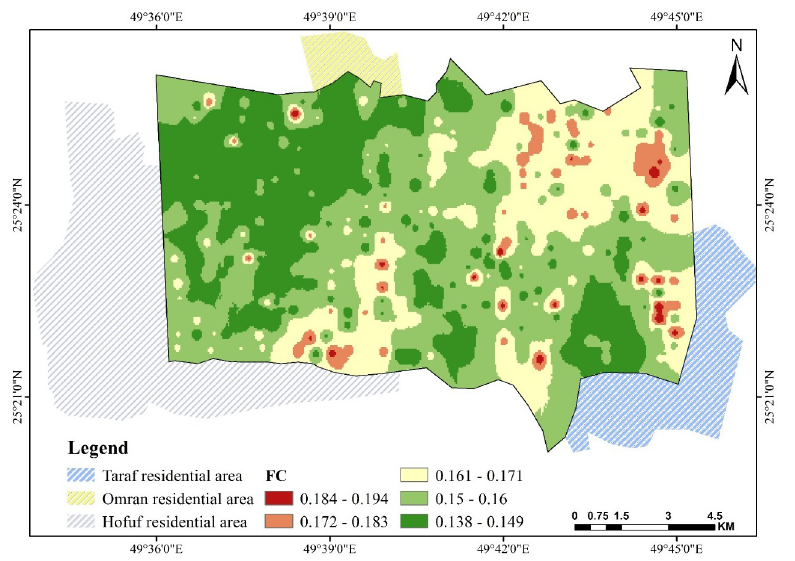
Fig 7. Spatial pattern of field capacity FC over